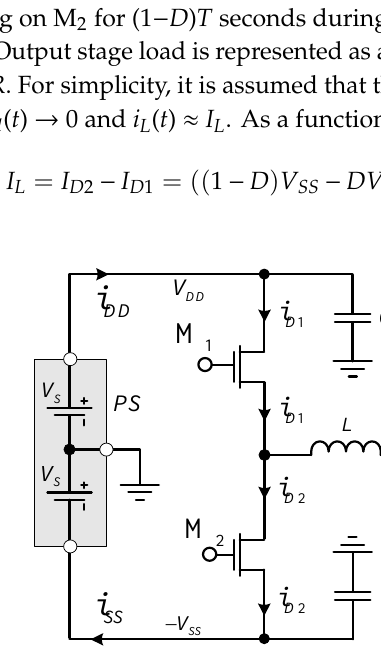
Figure 1. Basic configuration of class-D half-bridge (HB) amplifier without control circuitry. Amplifier output stage is powered by symmetrical supply with voltages V DD = V S and − V SS = − V S